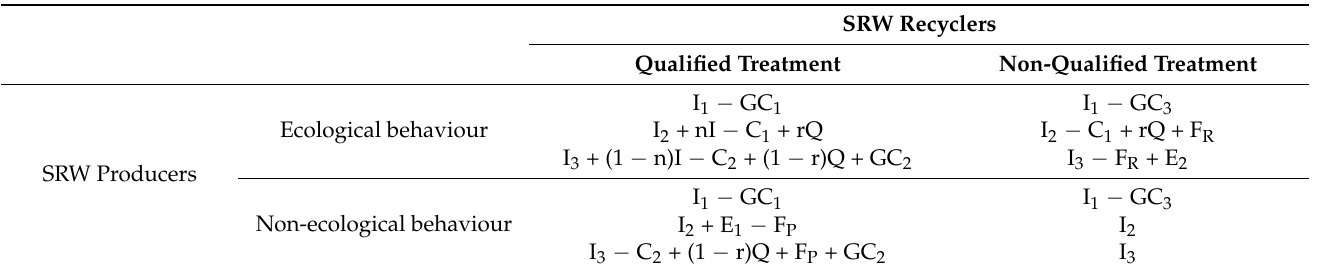
Table 2. Payoff matrix with governments that choose positive supervision.